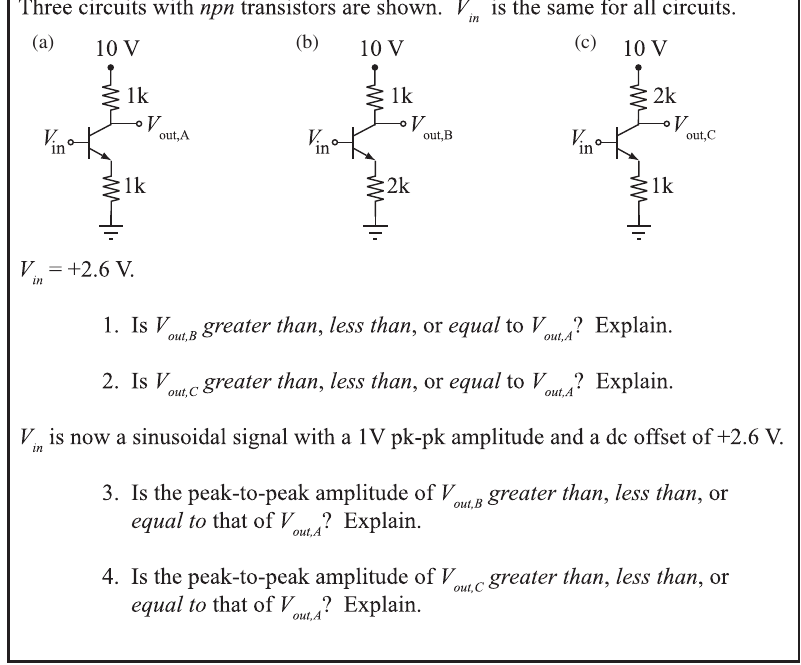
FIG. 8. Revised amplifier comparison task. Note that the text has been abridged and